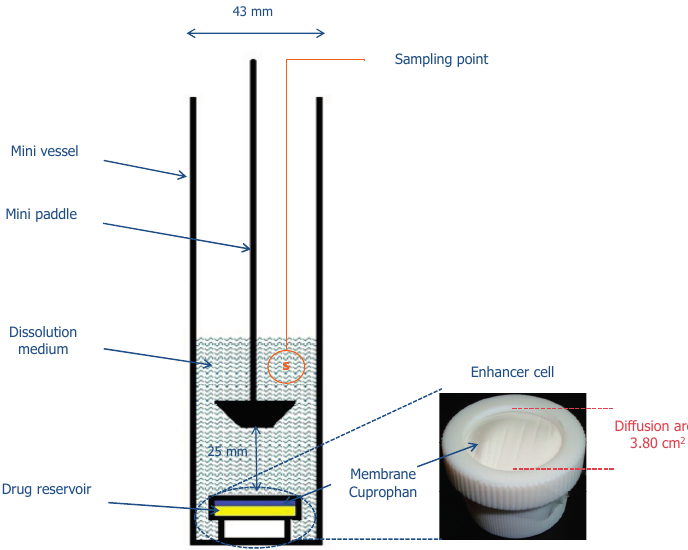
Figure 4. In vitro drug release study